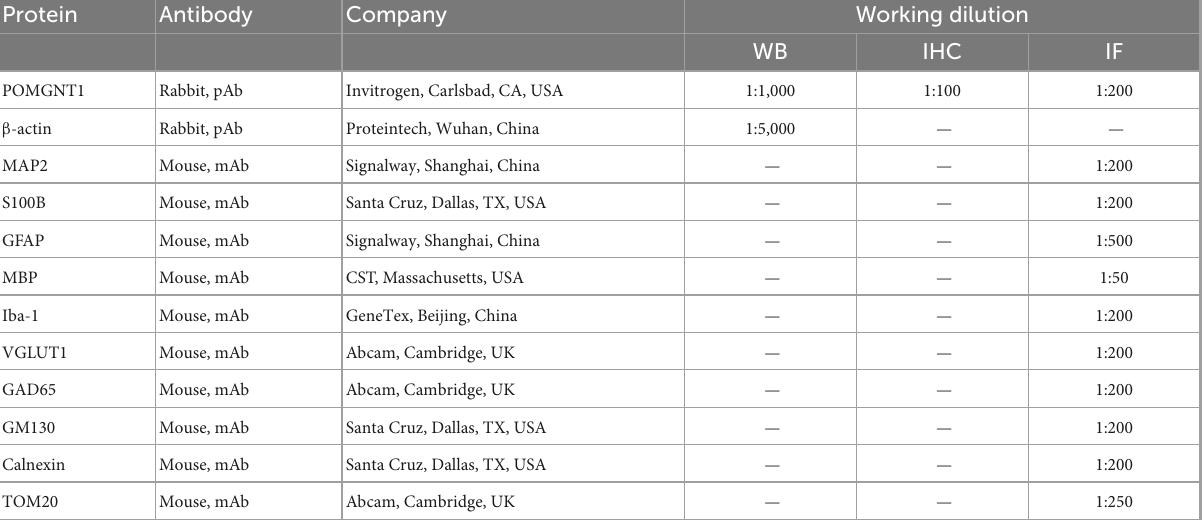
TABLE 1 Primary antibodies used in this work.